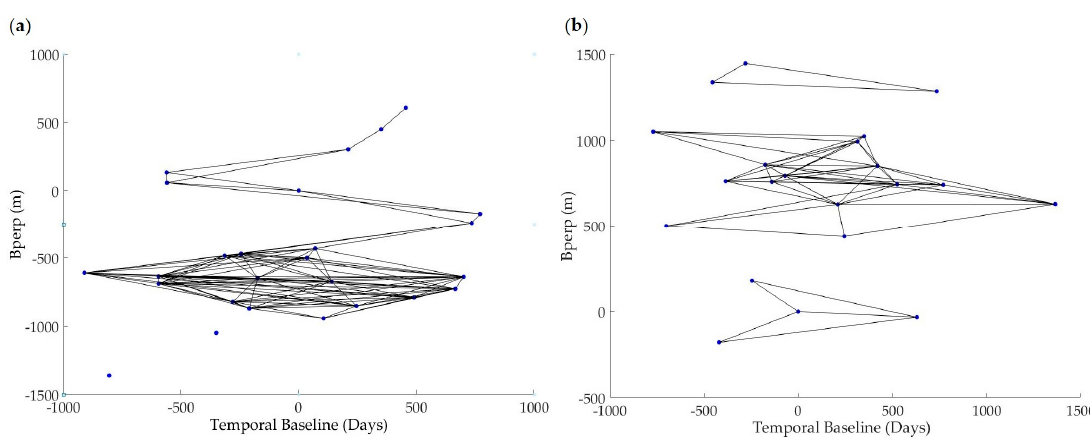
Figure 3. Temporal and perpendicular baselines of image pairs relative to the master. Image acquisitions are represented by points and differential interferograms, satisfying the orbital and temporal requirements, by lines: ( a ) ERS Synthetic Aperture Radar (SAR) (master: 20 November 1997); ( b ) ENVISAT Advanced Synthetic Aperture Radar (ASAR) (master: 11 January 2005).